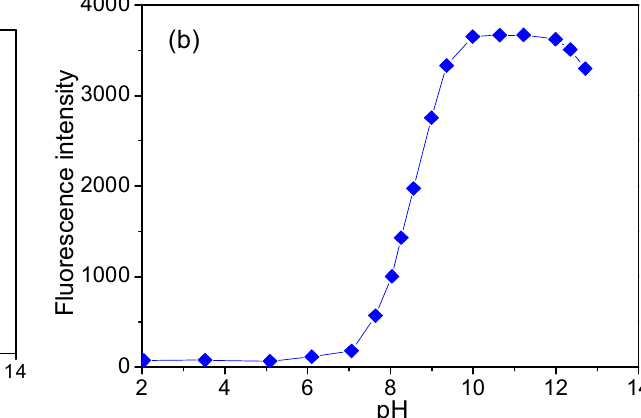
Figure 9. Fluorescence intensity of CH ( a ) and ECH ( b ) aqueous solution versus pH. c CH = 0.407 μ g·mL − 1 , c ECH = 0.204 μ g·mL − 1 , MeOH 10%, λ ex / λ em : 279 nm/410 nm. 3.7. HPLC Chromatograms of CH and ECH in Acidic Aqueous MOBILE phase To confirm the structural transformation of CH and ECH in protic solvents, CH, ECH and their mixture in methanol were analyzed by HPLC (Figure 10). All three chromatograms show a retention time of about 9.4 min. The same compound has the same retention time under the same chromatographic condition, which is the qualitative basis of HPLC. The above result confirms that CH and ECH transform into the same molecular structure in the experiment, which is consistent with the above conclusion.